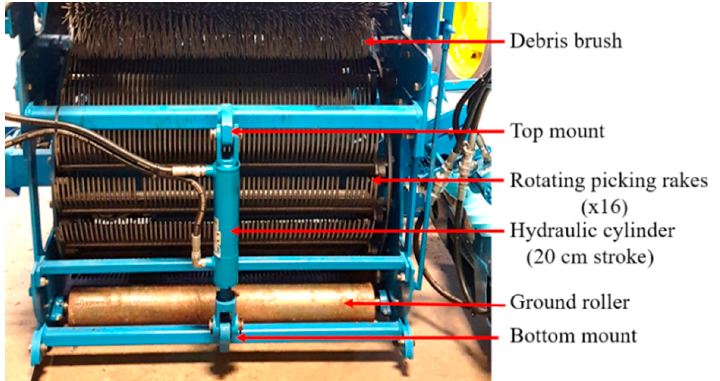
Figure 5. DBE harvester head showing components of the hydraulic actuator setup.